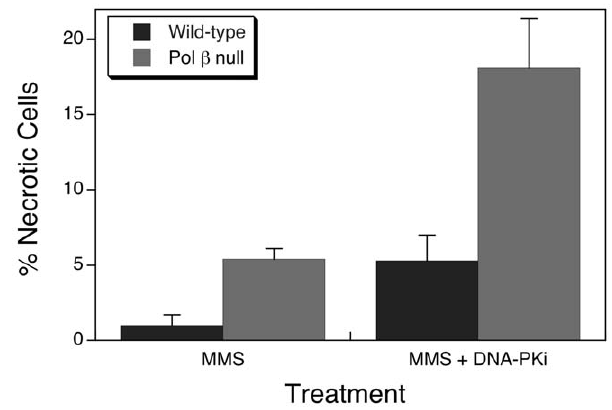
Figure 6. Necrotic cells measured by flow cytometry 24 h after treatment. Cells were treated with 10 mM MMS for 20 min at 4 u C, then cells were washed and incubated at 34 u C until harvested for analysis. The DNA-PK inhibitor, NU-7026 was co-treated with MMS for 20 min at 4 u C, then the MMS was removed and cells were incubated at 34 u C in the presence of NU-7026 until harvested for analysis (MMS + DNAPKi). Values represent the means 6 SEM of three independent experiments normalized to the control